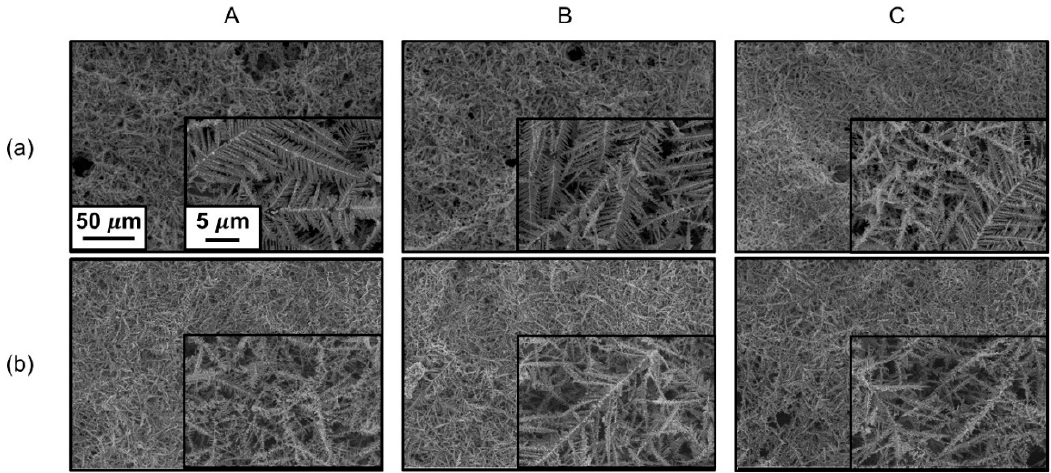
Figure 5. Cont. Figure 6. Cont